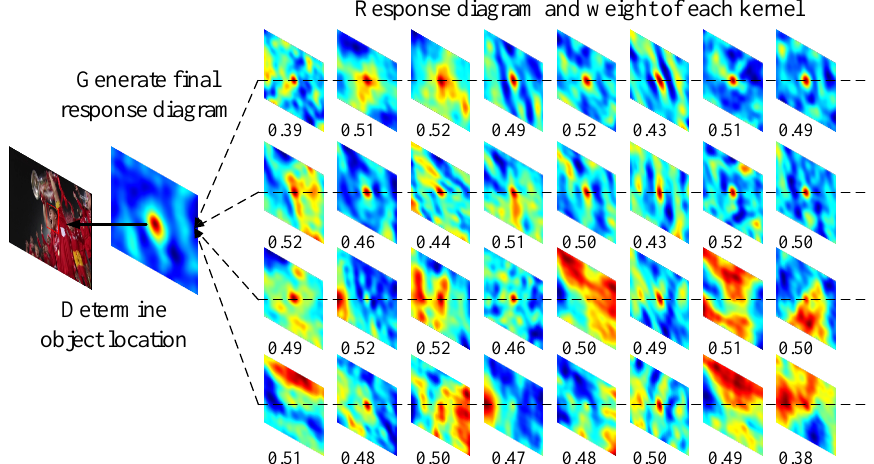
Figure 7. The results of SE attention module for each convolution kernel (“soccer” video se- quence).